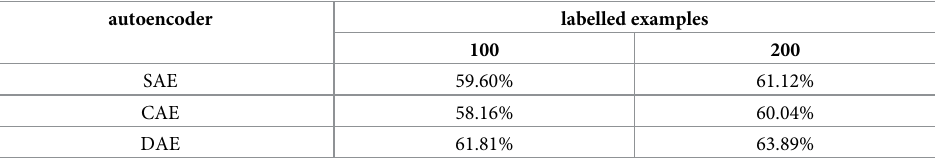
Table 6. On the Killer test set, results of the variant of autoencoders on our